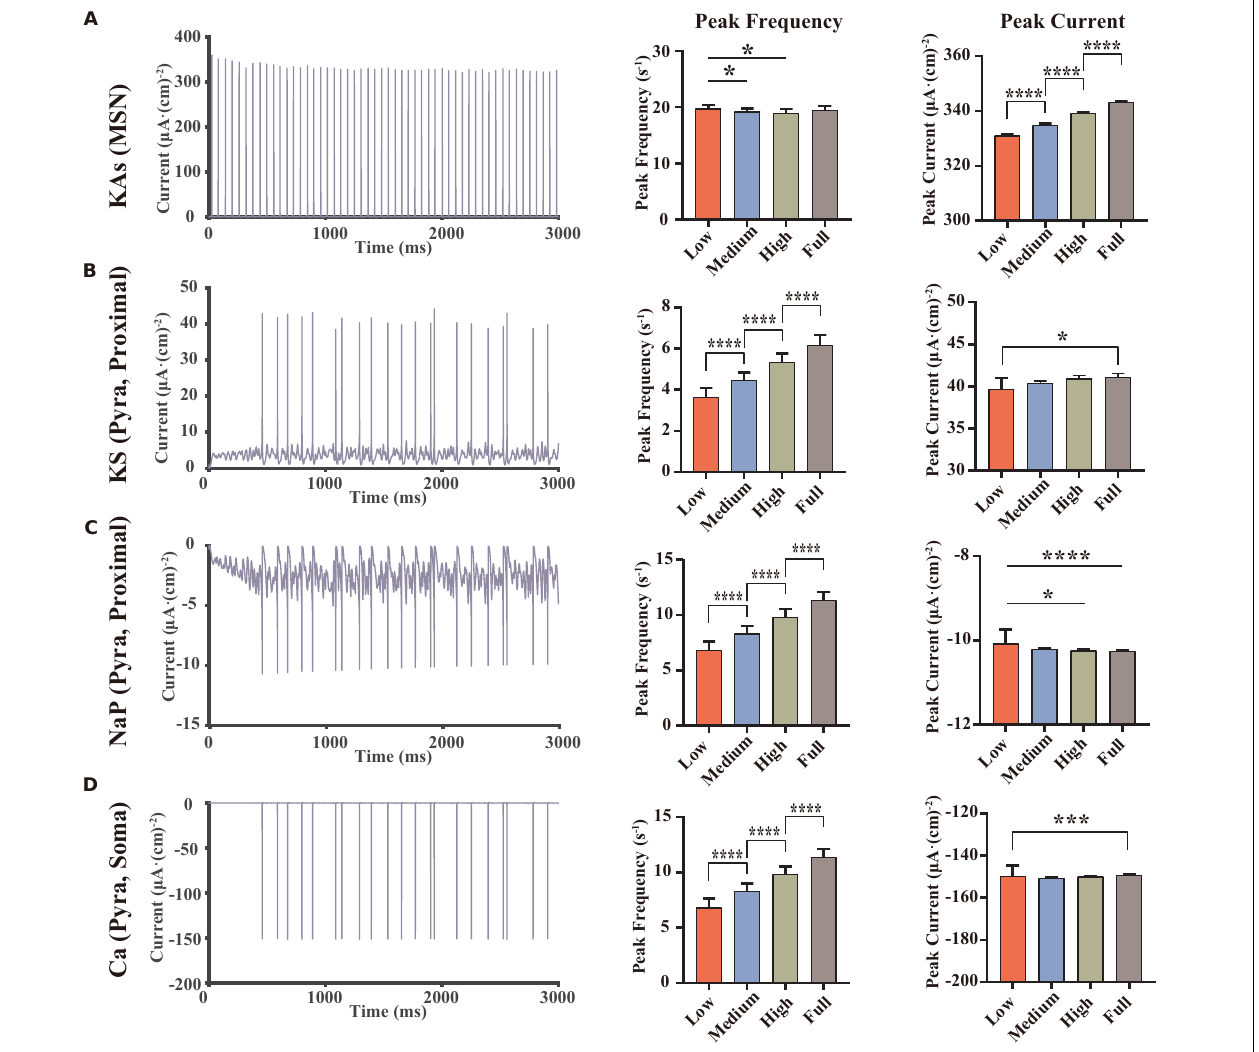
FIGURE 3 | Statistical results of some important ion channel currents, where each row showed a type of the currents [ A , KAs channel of MSNs, B , KS channel on the proximal dendrite of pyramidal neurons. (C,D) NaP and Ca channel on the soma of pyramidal neurons, at full dopamine concentration], left, examples for the currents of the corresponding ion channels, middle, statistical results of the peak frequencies (C,D converse), right, statistical results of the peak currents, using repeated measured one-way ANOVA (for normal distribution) or Friedman test (non-normal distributions) methods, n = 9. All the statistically significant differences were visualized in the graph. * p < 0.05, *** p < 0.001, **** p < 0.0001, means ± SEM.